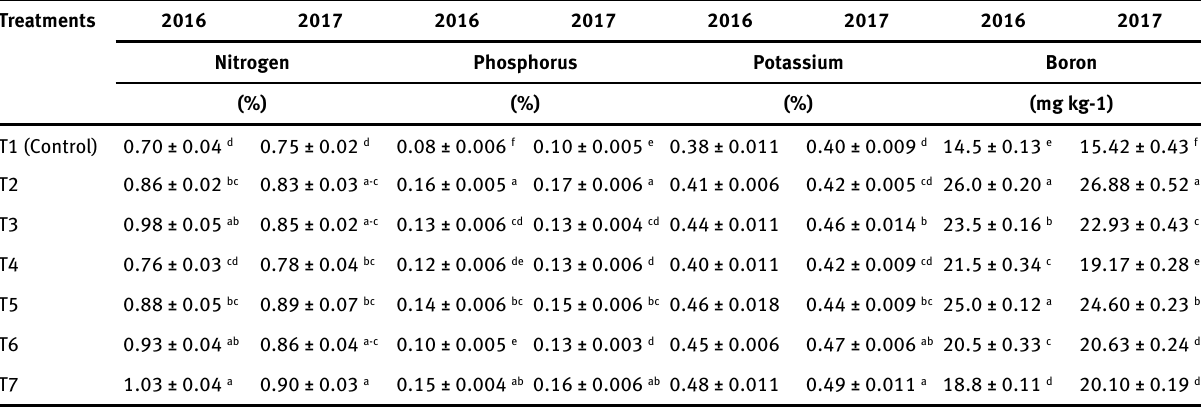
Table 4. Effects of foliar application of variable sources of Ca and K with Boric acid on N, P, K and B uptake in SB Chaunsa leaves